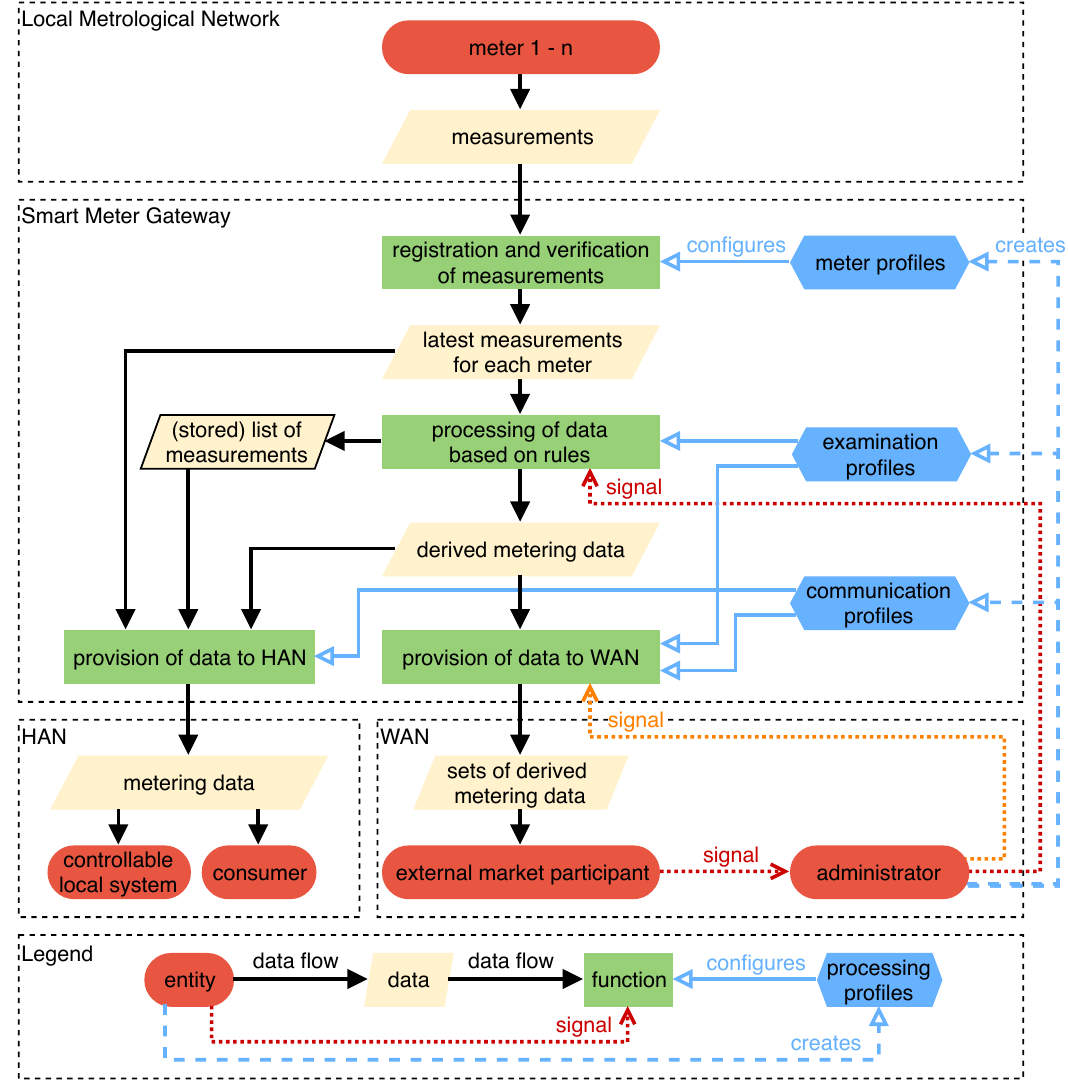
Figure 1. The processing of meter measurements by a Smart Meter Gateway, based on